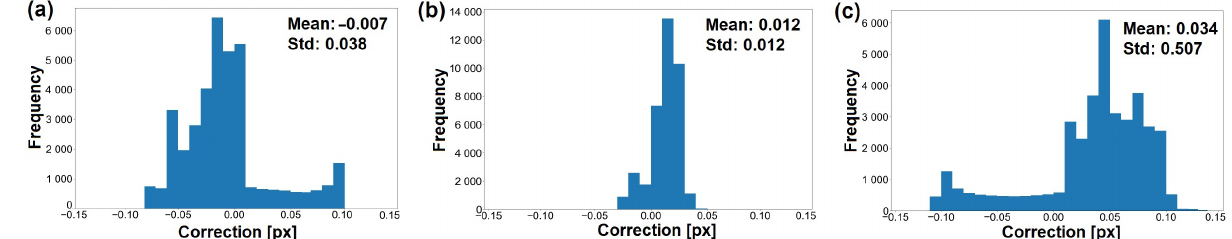
Figure 16. Histograms of correction values for Pléiades satellite imagery: ( a ) Forward image. ( b ) Nadir image. ( c ) Backward